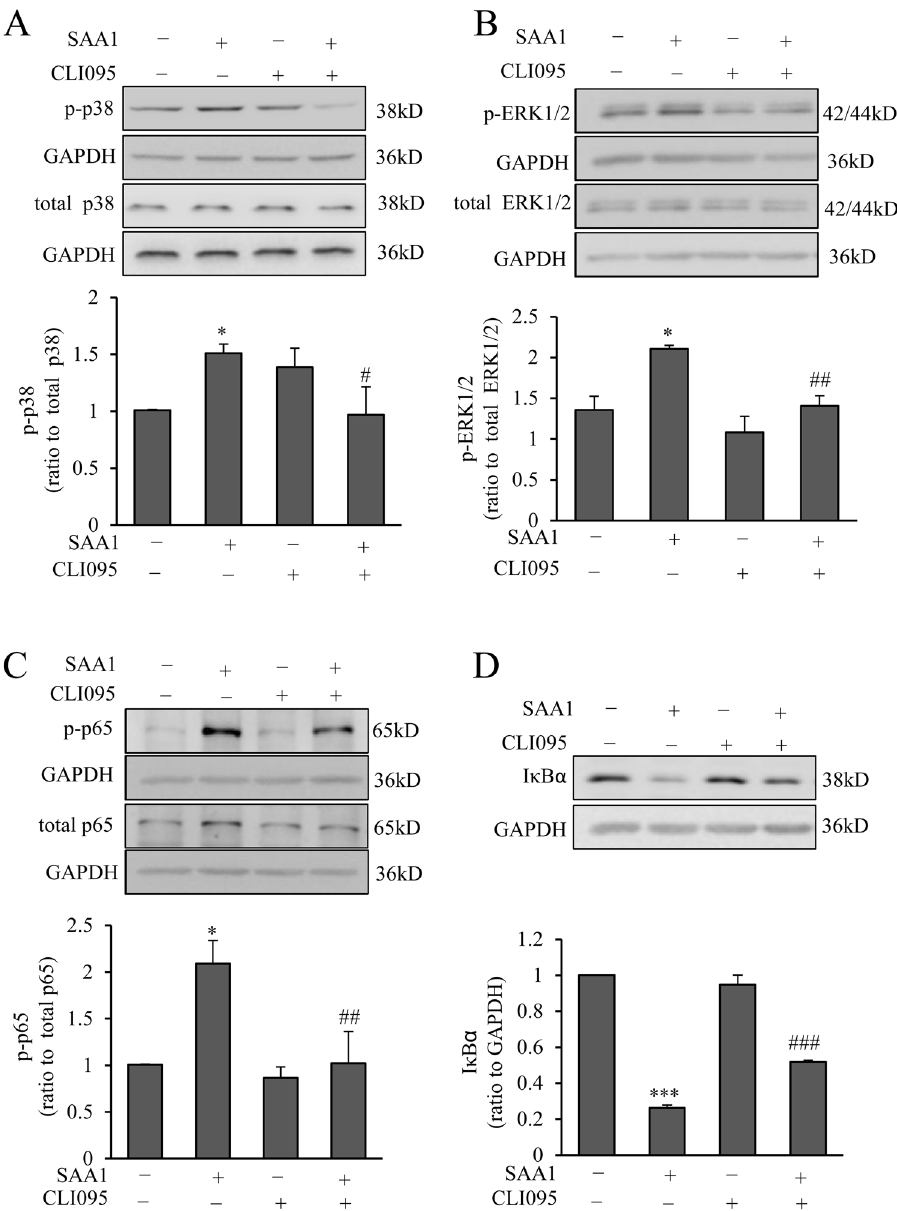
Figure 6. Role of TLR4 in the activation of MAPKs and NF- κ B pathways by SAA1 in human amnion fibroblasts. Effect of TLR4 inhibitor CLI095 (5 μ M) on the increases in the phosphorylation of p38 ( A , n = 5), ERK1/2 MAPKs ( B , n = 4) and p65 ( C , n = 4), and the decrease in I κ B α ( D , n = 4) abundance induced by SAA1 (10 ng/mL, 60 min) in human amnion fibroblasts. Top panels are the representative immunoblots. Data are the means ± SEM. Statistical analysis was performed with one-way ANOVA test. * P < 0.05, *** P < 0.001 vs. control (0), # P < 0.05, ## P < 0.01, ### P < 0.01 vs.